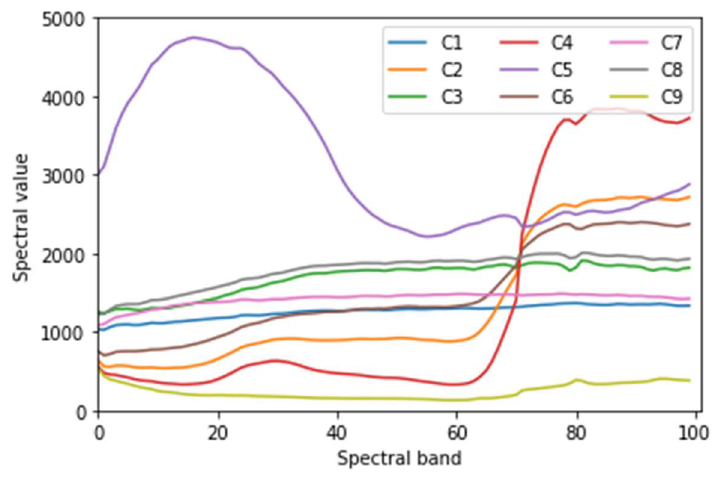
Figure 10. Mean spectral signatures of 16 classes in the Pavia University dataset.